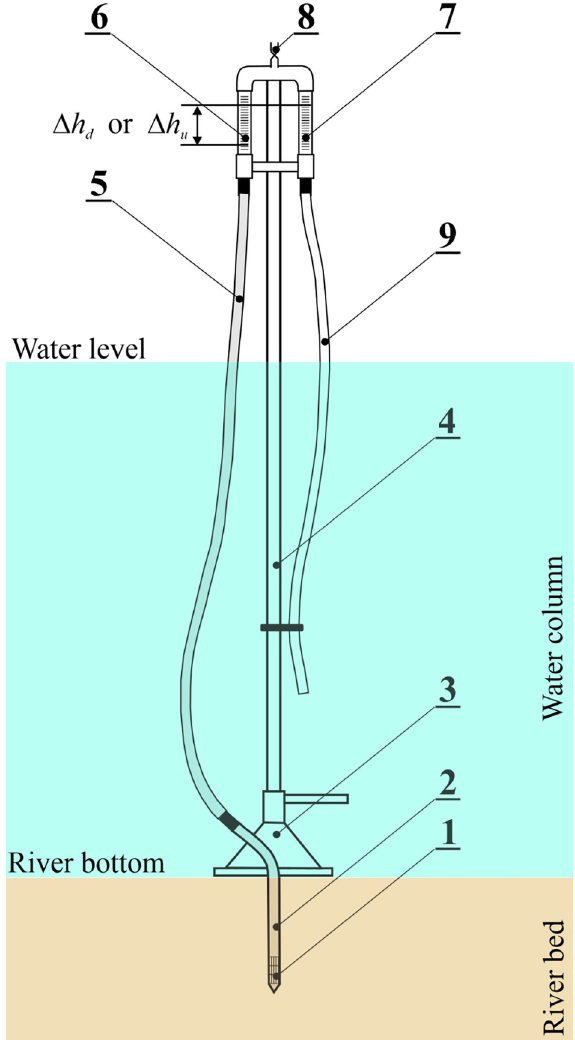
Fig. 4. Construction of a gradientmeter. 1 – screen, 2 – piezometer embedded into bottom sediments, 3 – pressure ring, 4 – bracket, 5 – hose to piezometer, 6 – piezometer measuring tube, 7 – measuring tube for surface waters, 8 – valve, 9 – hose submerged in